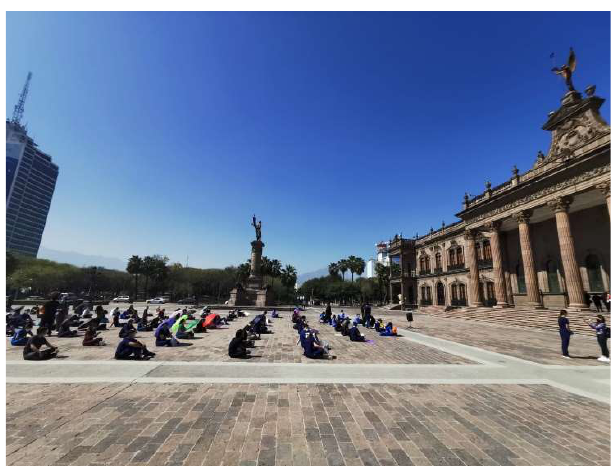
Figure 1 . Medical Students in Front of the Monterrey City Hall (side view).